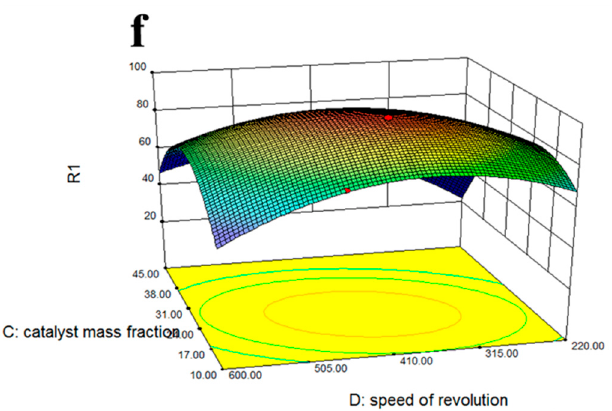
Figure 11. Effect of esterification conditions on the conversion of levulinic acid. Setting conditions: